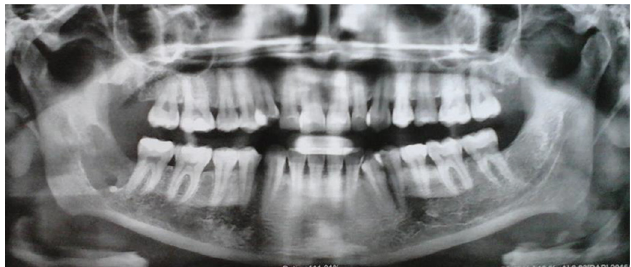
Fig. 2. Orthopantomography performed at the fi rst visit showing an unilocular, well-delimited, radiolucent lesion behind the mandibular right 2nd molar and a residual apex of the 3rd molar.